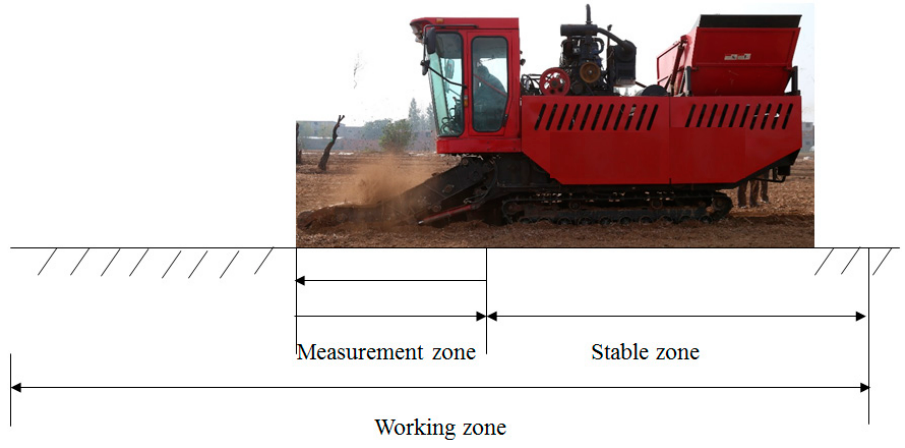
Figure 12. Distribution of harvest field test.